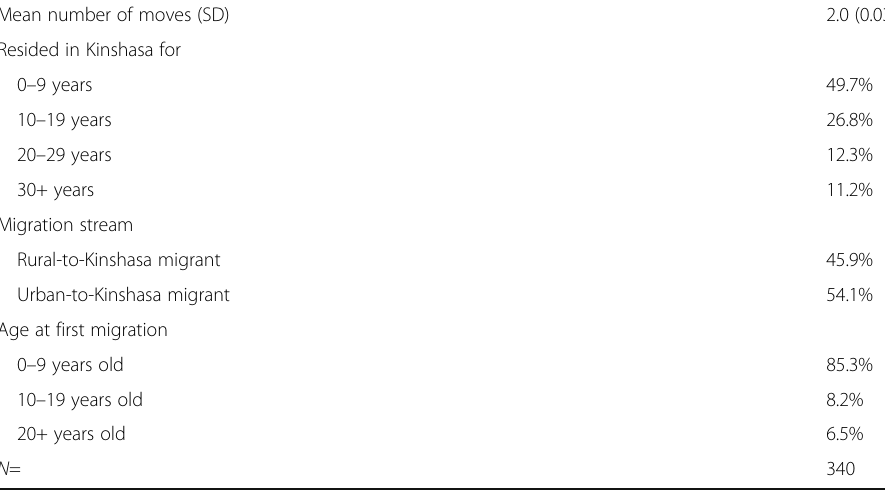
Table 2 Migration characteristics, PMA2020 Project, Kinshasa 2013 Mean number of moves